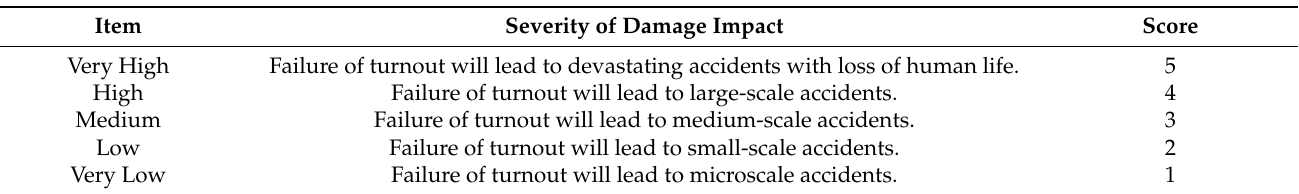
Table 2. Sensitivity